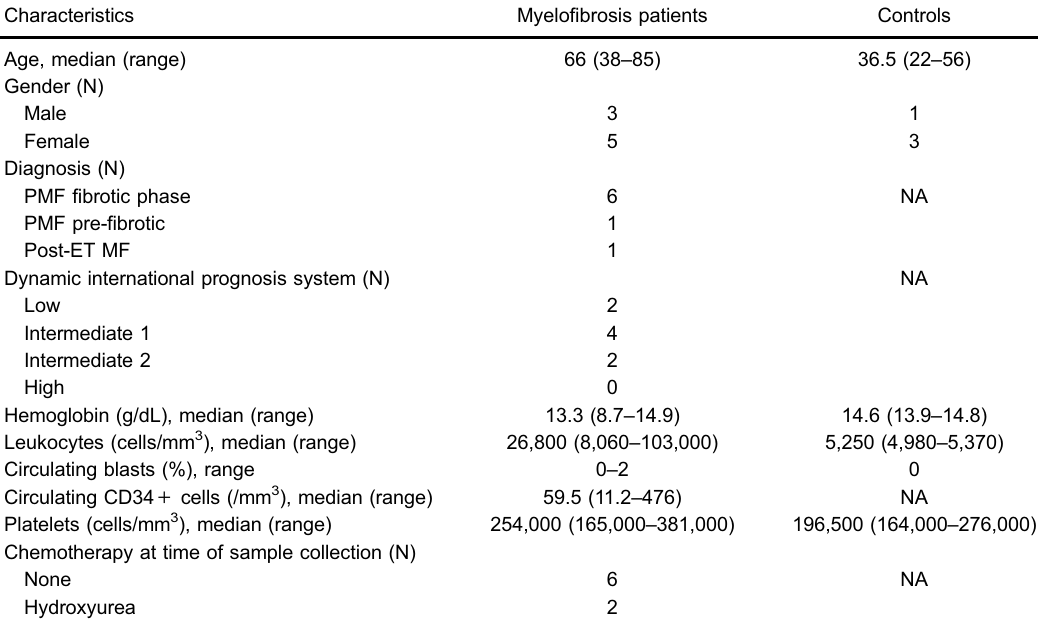
Table 1. Main epidemiologic and clinical characteristics of myelo fi brosis patients and controls.